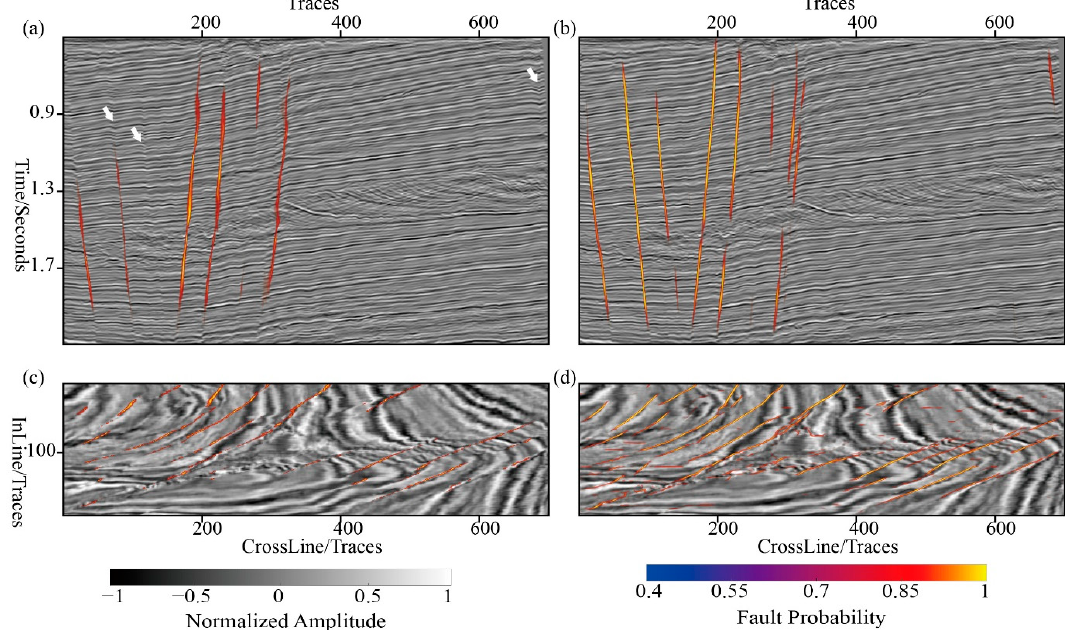
Figure 12. Comparison of the faults detection results on 2D slices by using the pre-trained U-Net model (left column) and the U-Net model after transfer learning (right column). Vertical slice and horizontal slice are inline 50 (( a ) and ( b )) and time = 1200 ms (( c ) and ( d )), respectively.